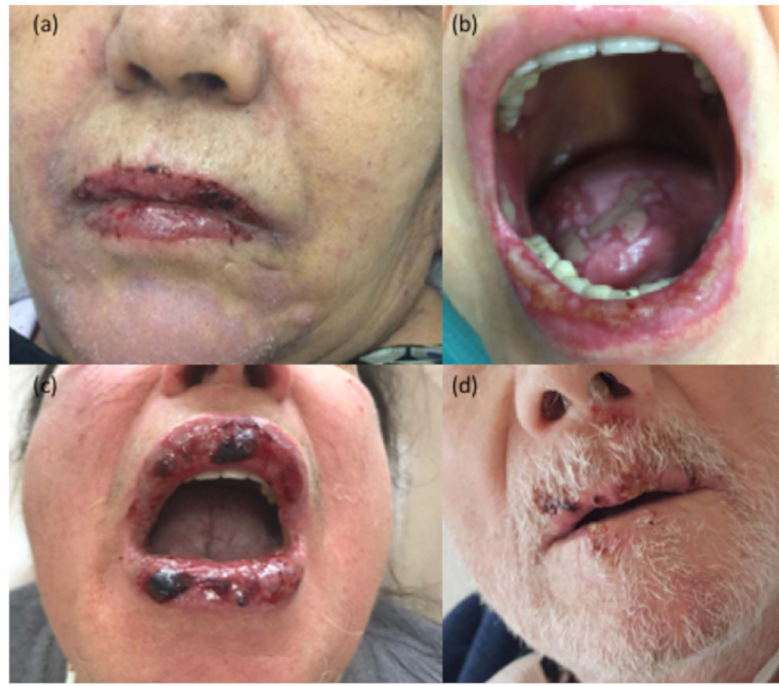
Figure 5. Steven-Johnson syndrome in patients in treatment with immunotherapy with Anti-PD1 (nivolumab and pembrolizumab) affecting the lips ( a,b,c,d ) or the tongue ( b